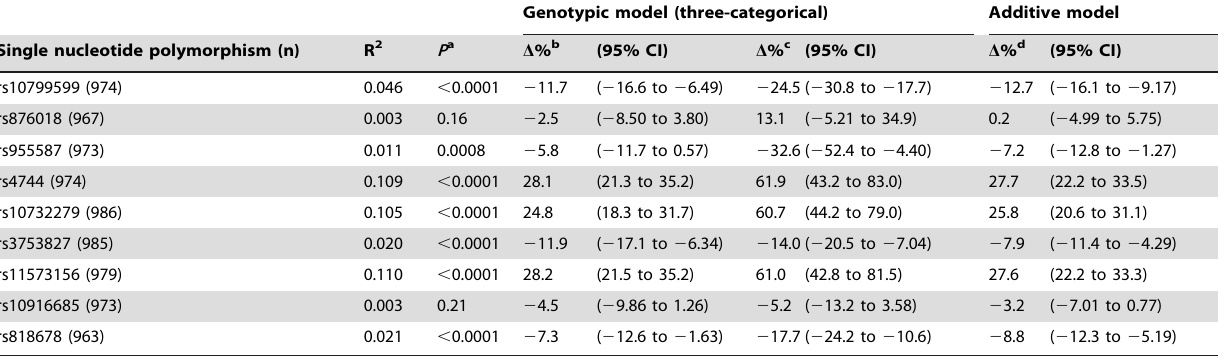
Genotypic model